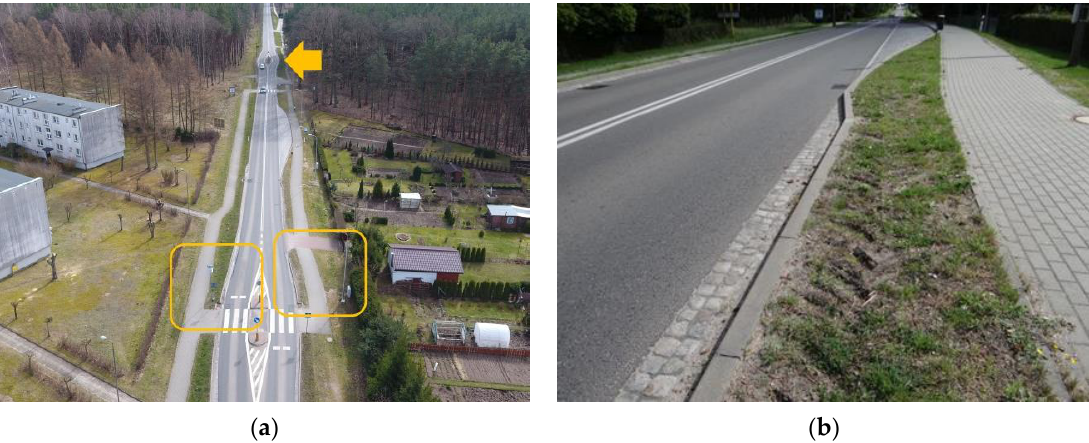
Figure 15. Example of poor design in village transition zone: ( a ) example of high kerbing installed at the pedestrian refuge situated ca. 150 m from the central island; ( b ) grass strip deterioration caused by overrunning vehicle tyres, past the pedestrian refuge depicted in Figure 11a. Source: own work of the authors.